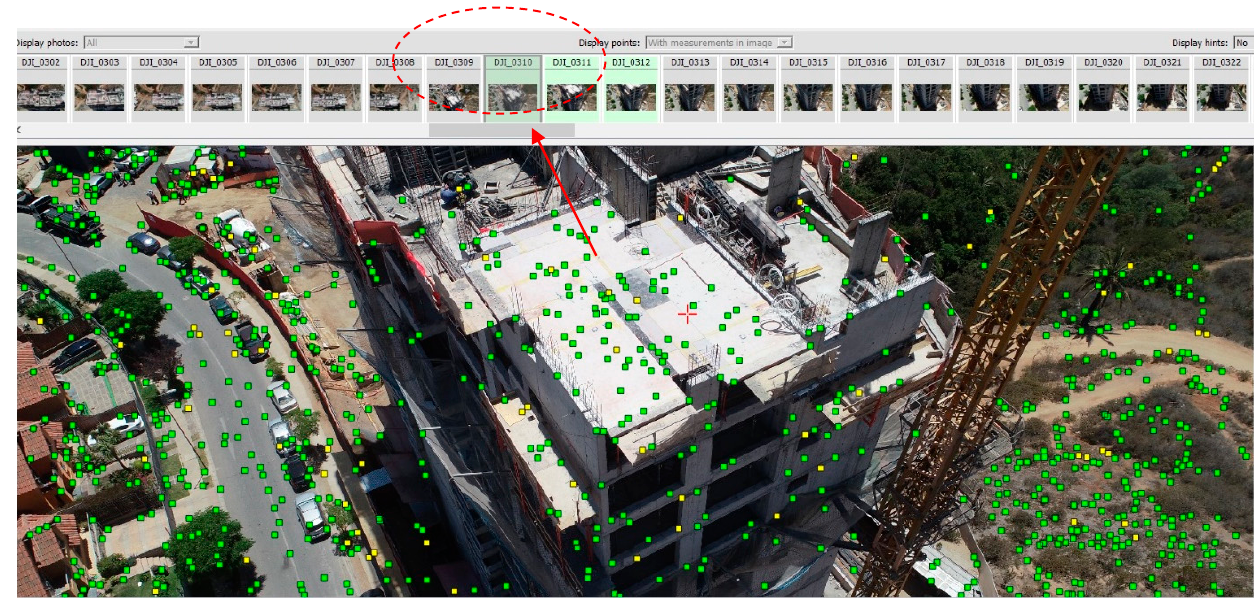
Figure 6. Key points detected in the image set during aerotriangulation.